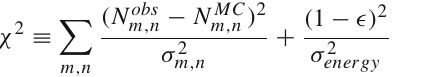
for each event sample. Some of the templates are shown in Fig. 26.